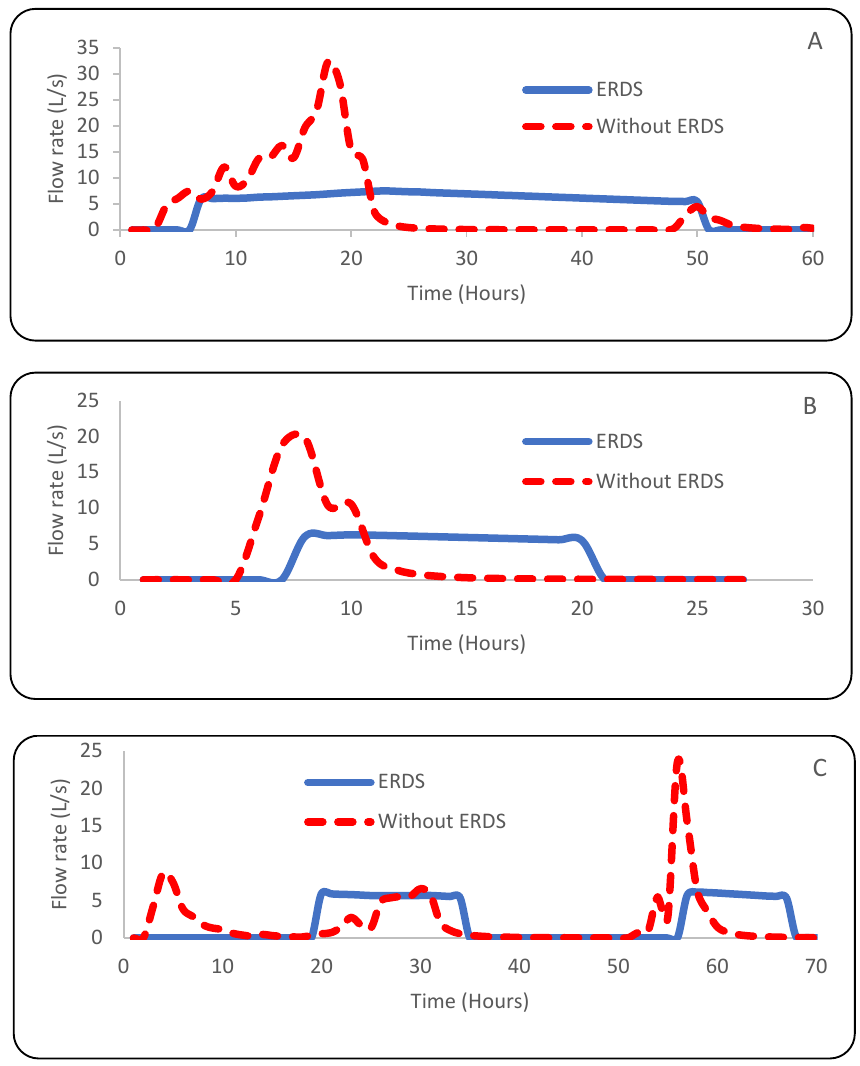
Figure 8. The modeled peak flow reduction for events occurring on ( A ) 24 January 2020. ( B ) 18 February 2020 ( C ) 1 to 4 March 2020 for two scenarios during the winter season.